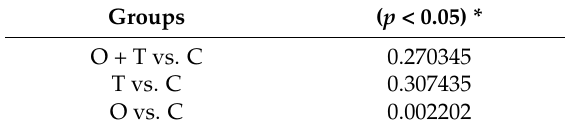
Table 3. Mann-Whitney post-hoc statistical test for the precursor B cells/Pro-B cells.